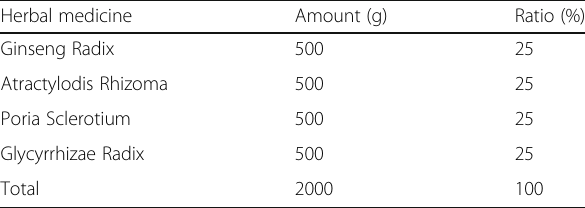
Table 1 Composition of Sagunja-tang (SGT) preparation